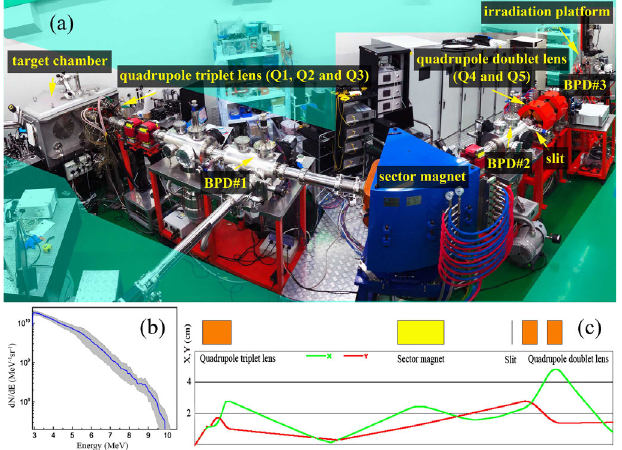
FIG. 1. CLAPA beam line: (a) Panoramic photograph of the beam line. (b) Measurement of the proton spectrum with a Thomson spectrometer placed 140 mm behind the target based on a 2 . 5 μ m aluminum foil [32]. The solid line is averaged over ten shots and the gray area is the rms deviation. During the beam line experiment, this Thomson spectrometer was replaced by the quadrupole triplet lens. (c) Simulated envelope evolution of the proton beam for a tailored energy distribution with a central energy of 4.62 MeV and energy spread of (cid:1) 3 %, using the program TRACK. The radius of the initial beam spot is set to 5 μ m and the acceptance angle is (cid:1) 50